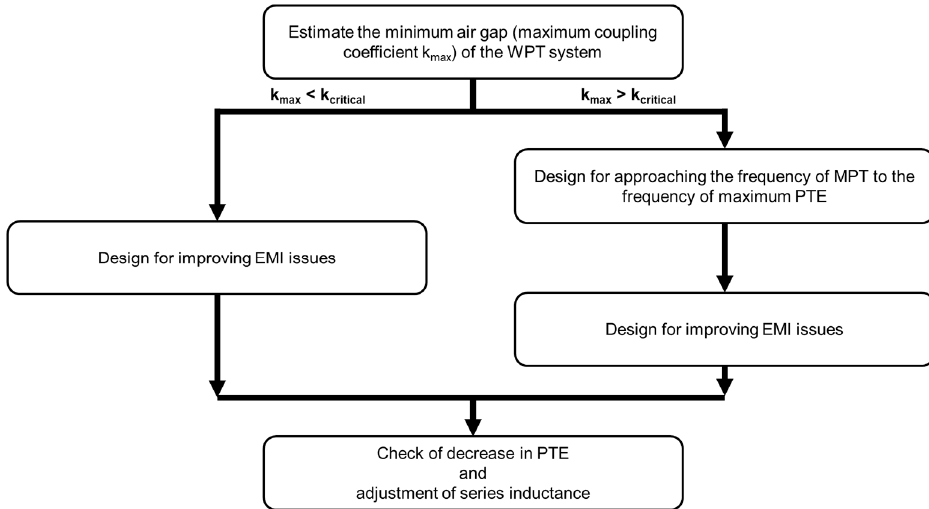
Figure 11. Design considerations of series inductors according to the maximum coupling coefficient of the WPT system.